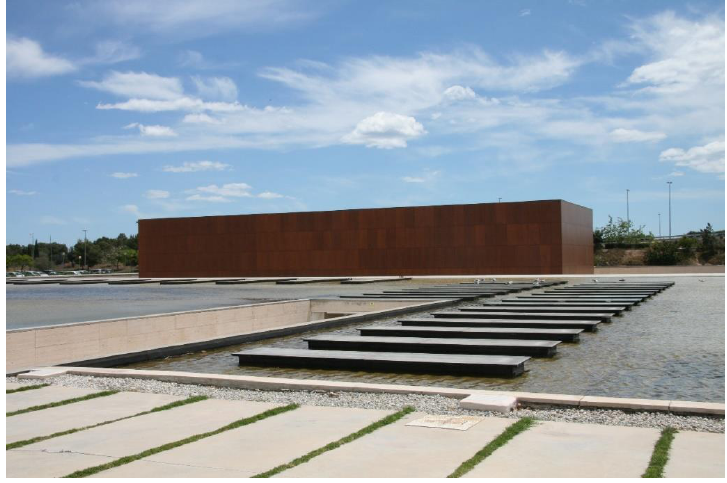
Figure 3. Image of the Museum of the University of Alicante (MUA). The Sempere Hall is below the water-covered roof, on the left.